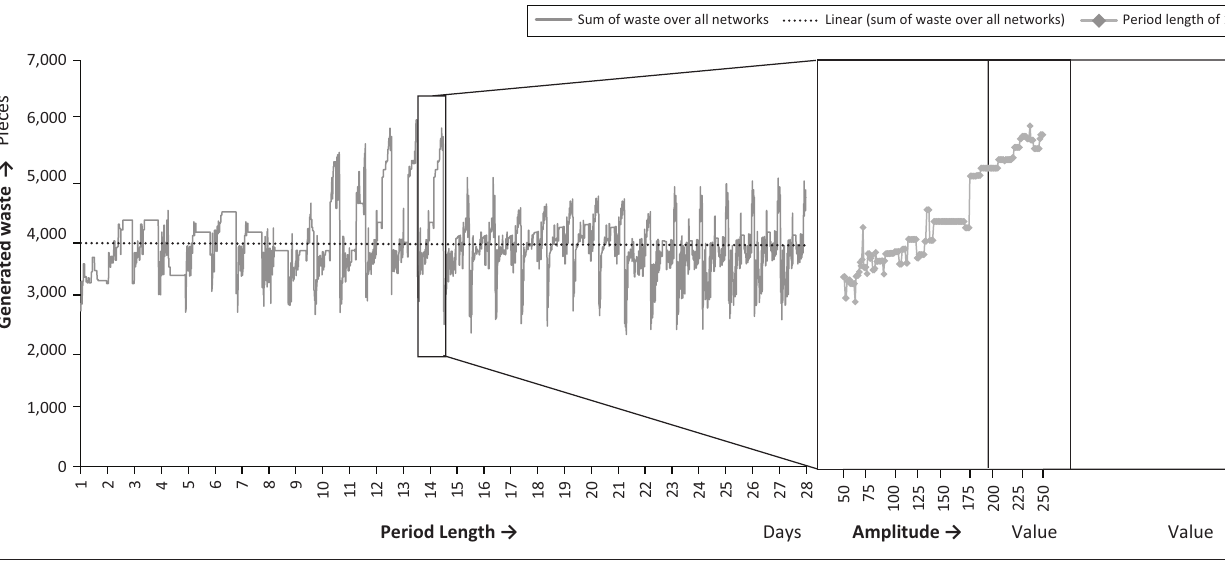
FIGURE 7: Left: Sum of the generated waste for each period length over every amplitude; right zoom into exemplary waste-chart for period length of 14: Waste over